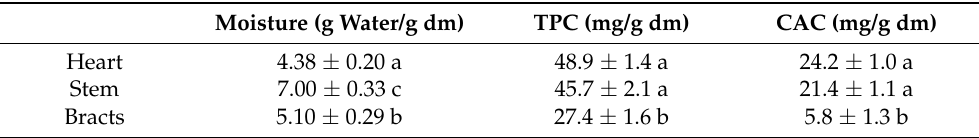
Table 1. Moisture content, total phenolic content (TPC) and chlorogenic acid content (CAC) of the artichoke heart, stem, and